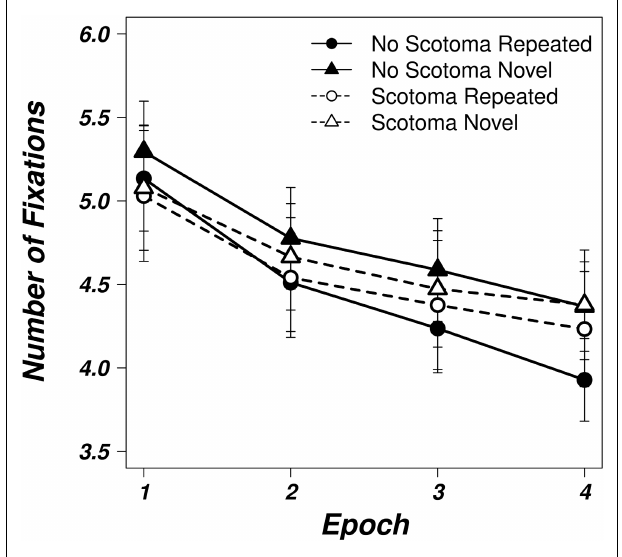
FIGURE 3 |Averaged number of fixations for the unimpaired (solid, filled symbols) and scotoma (dashed, open symbols) viewing conditions for repeated (circles) and novel (triangles) displays as a function of epoch. Error bars represent the standard error of the